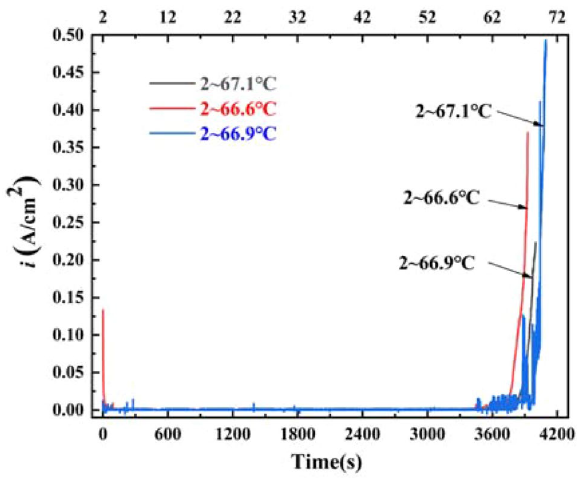
Figure 1. Critical pitting temperature curve of 2205 duplex stainless steel in simulated solution containing 100 g/L Cl − and saturated CO 2